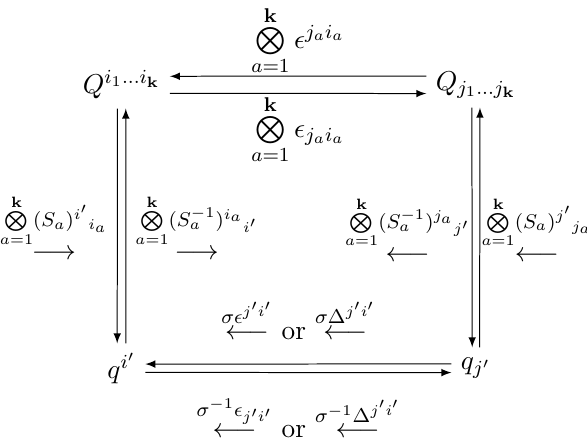
Figure 3 . Commutative diagram relating the k -fold fundamental and antifundmental operators in the standard basis and the \basis of eigenvectors" of the moment map. The arrow under N S a , N S 1 (cid:0)